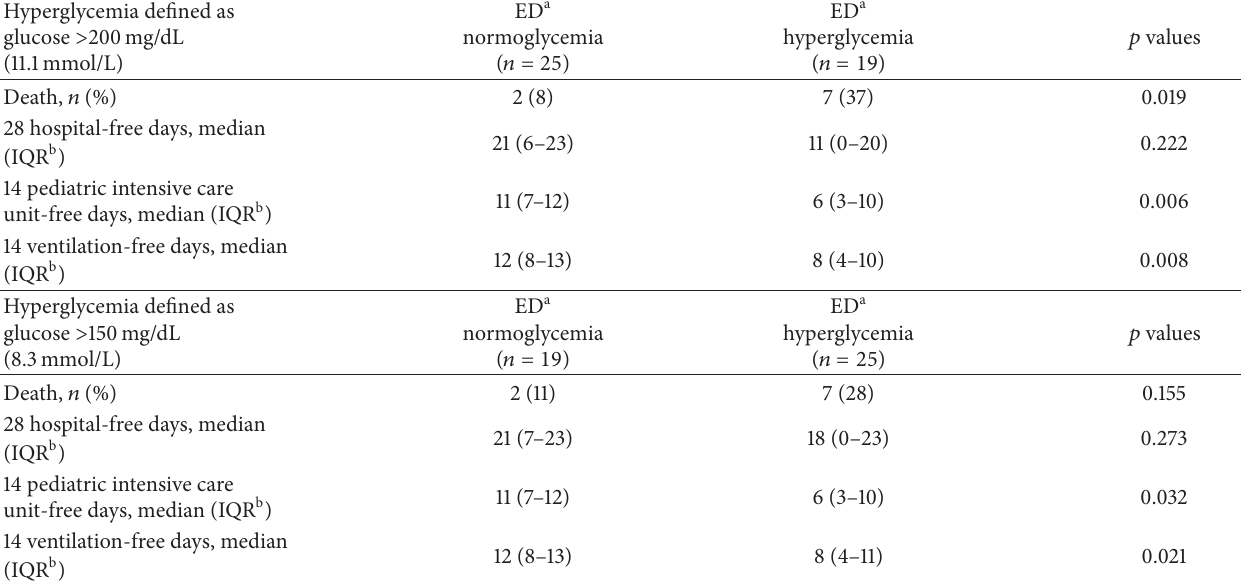
Table 2: Presenting glucose as a predictor for clinical outcomes in patients with GCS ≤ 13.